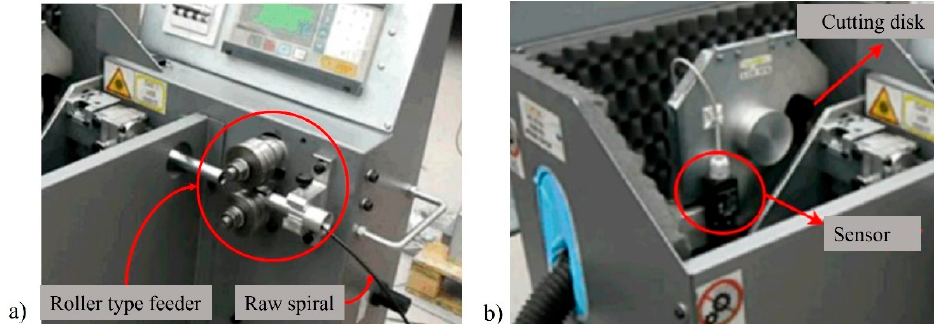
Figure 3. Details of the cutting machine: ( a ) roller type feeder and ( b ) sensor to control disk wear.